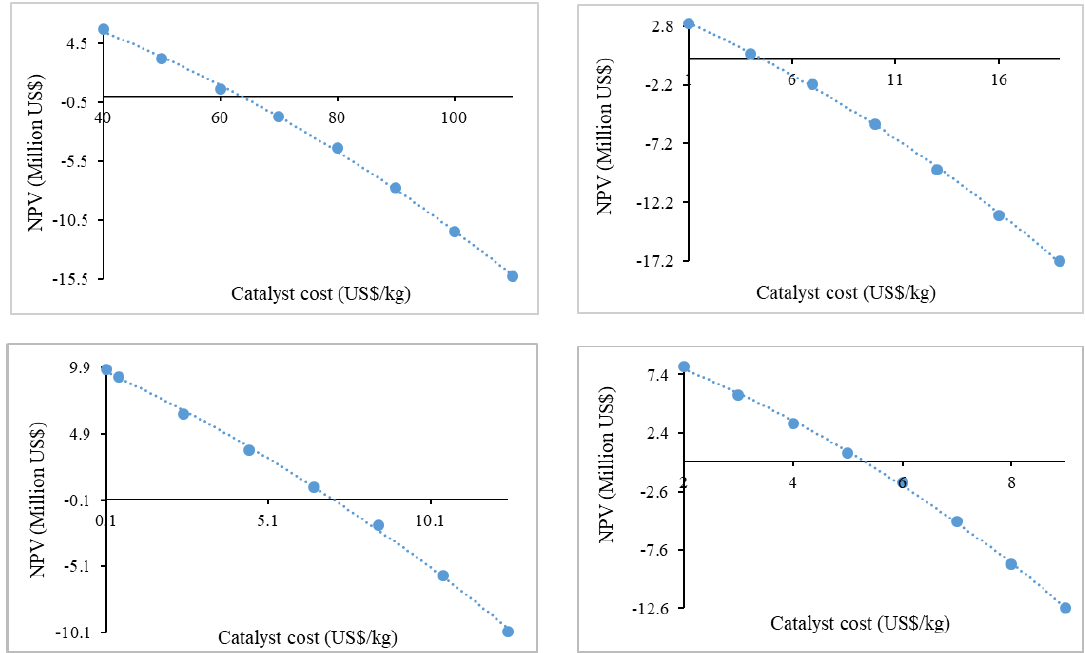
Figure 7. Effect of change of catalyst purchasing cost on NPV of each production technology option. Figure 7. E ff ect of change of catalyst purchasing cost on NPV of each production technology